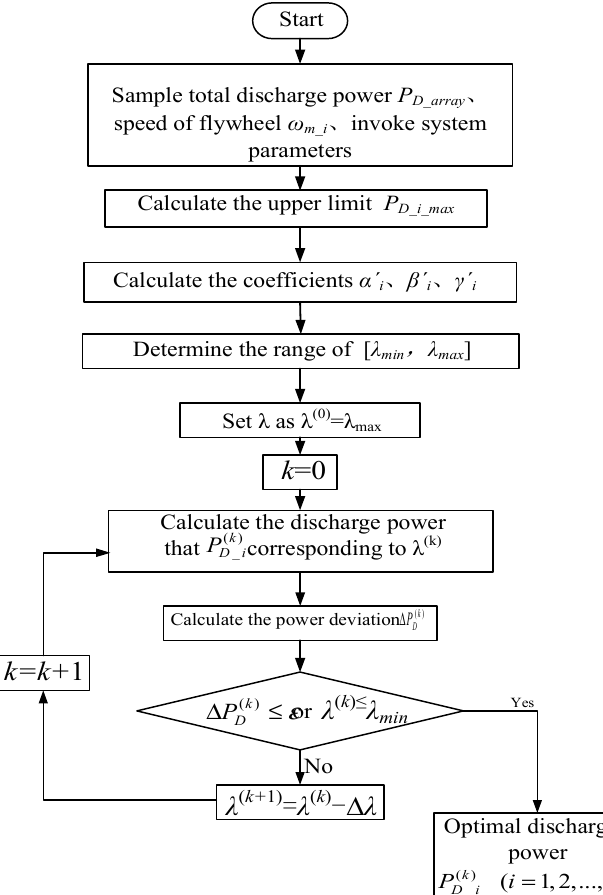
Figure 14. Flow sheet of discharging coordination control based on the equal incremental principle.